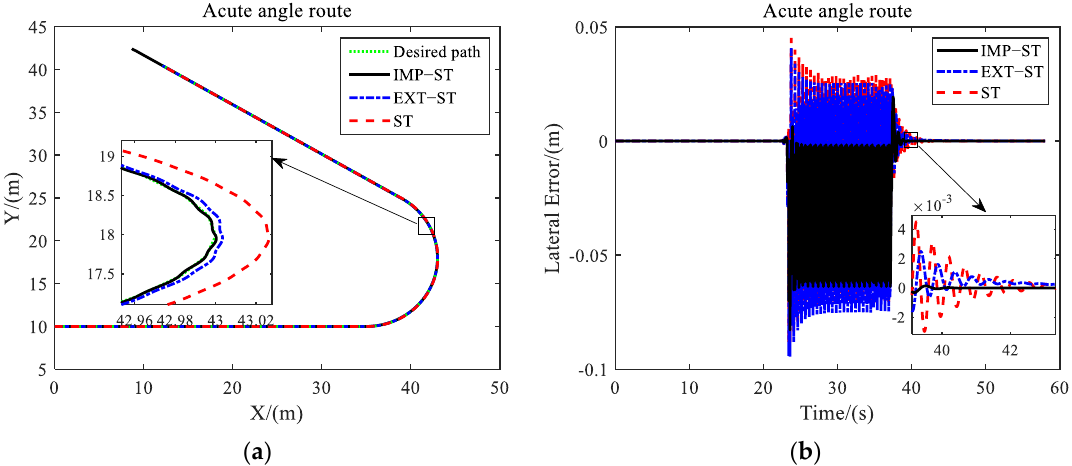
Figure 11. Path tracking performance comparison of three controllers for the acute angle route. ( a ) trajectory; ( b ) lateral error.